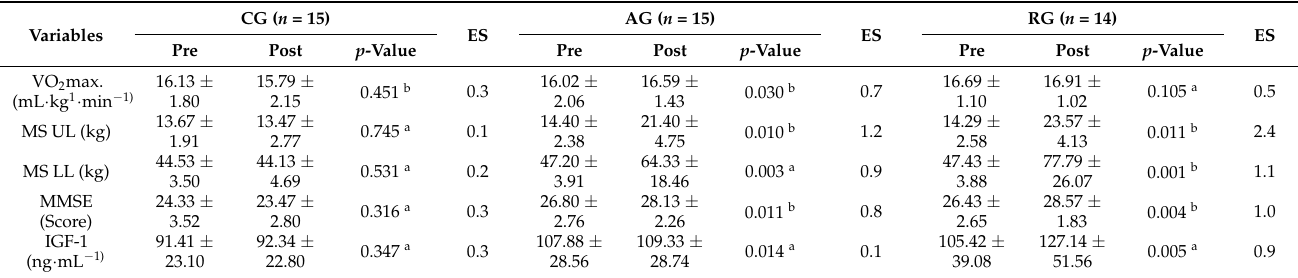
Table 5. Intergroup comparison pre- and post-test of aerobic capacity (VO 2 max), maximum muscular strength (MS) of upper limbs (UL), lower limbs (LL), cognitive state (MMSE), and growth factor concentration (IGF-1).